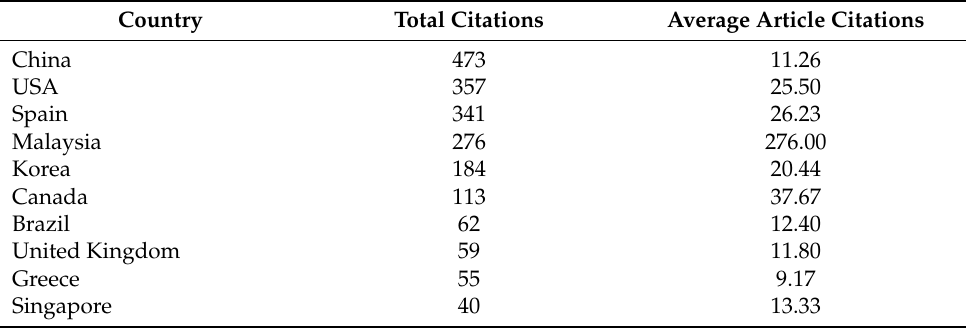
Table 9. The most cited